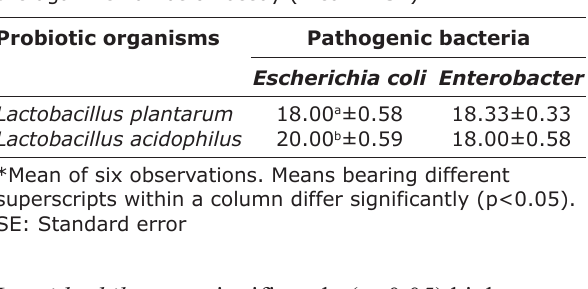
Figure-2: Optical density of de Man Rogosa Sharpe medium containing Lactobacillus acidophilus at various pH measured at 2 hourly intervals at 650 nm. Table-1: Antimicrobial activity of Lactobacillus spp. as demonstrated by the inhibition zone produced (mm) in the agar well diffusion assay